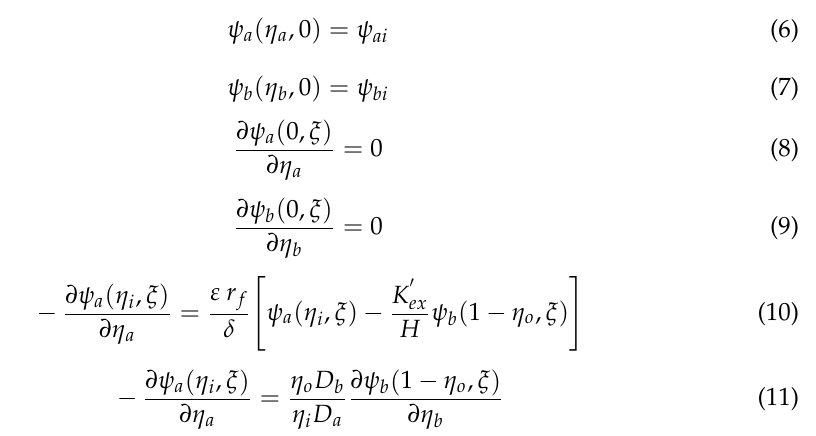
Figure 3. Four regions considered for modeling CO 2 absorption in hollow-fiber membrane contac- tors.